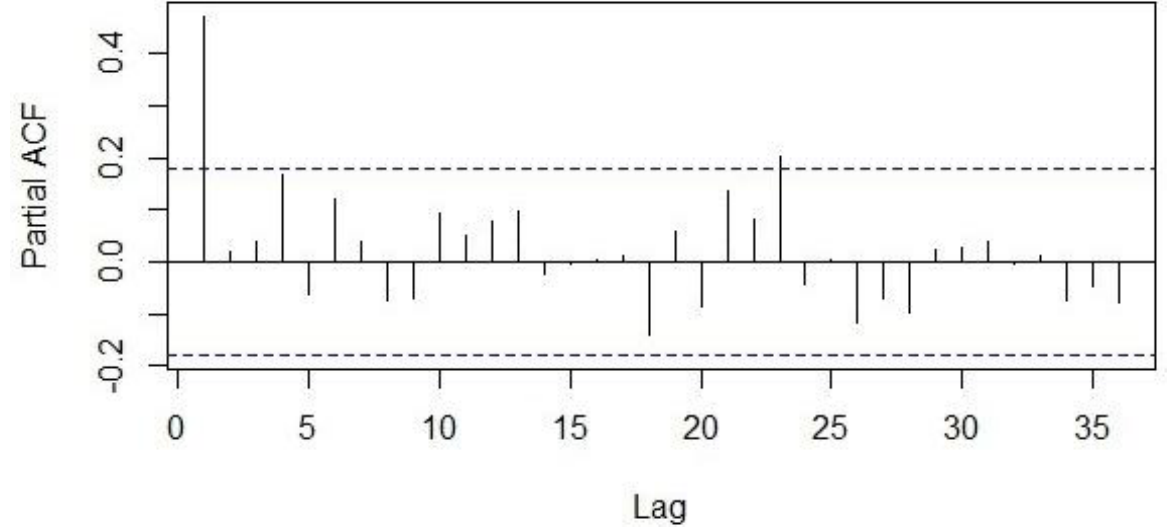
Fig. 6. The partial correlation chart of the ARIMA model